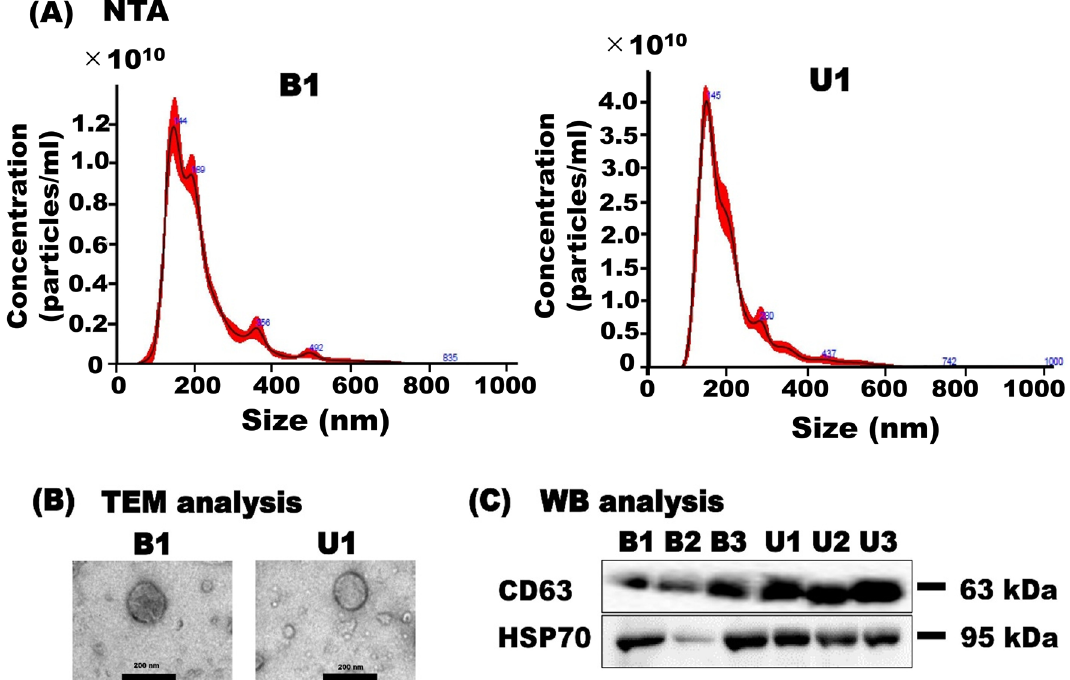
Figure 1. Milk sEV characterization. The peak (mode) of particle size distribution of the milk sEV from BLV- infected and uninfected cattle were showed by NTA. Representative data from B1 and U1 cattle were shown ( A ). Similar spherical morphology of milk sEV between BLV-infected and uninfected cattle were observed by TEM analysis. Scale bar shows 200 nm ( B ). Milk sEV were successfully detected by WB analysis using antibodies against sEV-surface-marker protein CD63 and internal protein HSP70 (C).